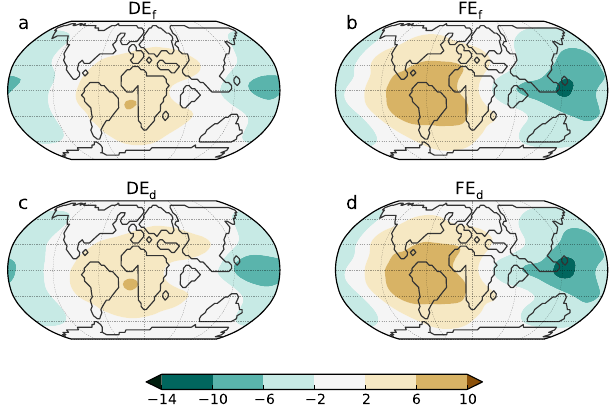
Figure 5. Velocity potential at 200hPa at the end of the desert world simulation (a) , forest world simulation (b) , DE d simulation (c) , and FE d simulation (d) . The average over the last 30 years of each sim- ulation is considered. The DE d simulation and the FE d simulation start from the desert world simulation and the forest world simu- lation, respectively. Brown colours indicate to a positive velocity potential, upper-air convergence, and subsidence. Green colours in- dicate to a negative velocity potential, upper-air divergence, and ris-